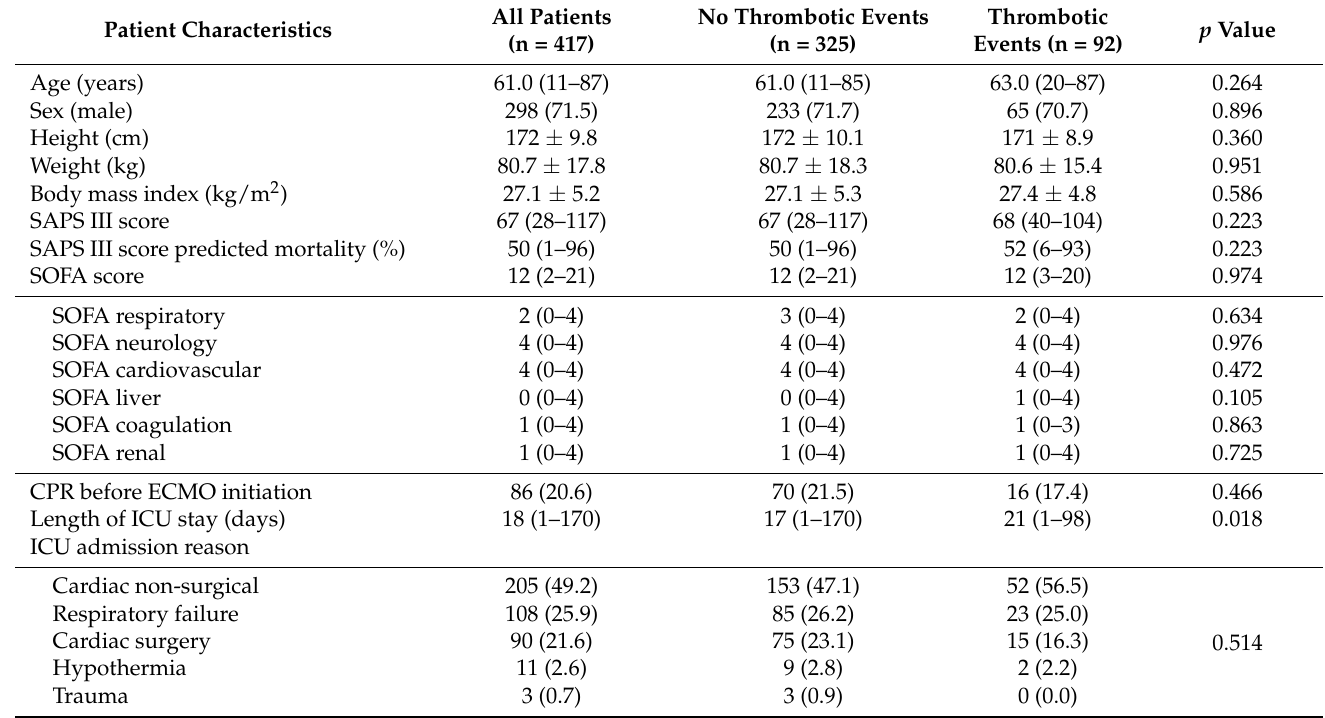
Table 1. Demographic and clinical characteristics of the included patients (n =